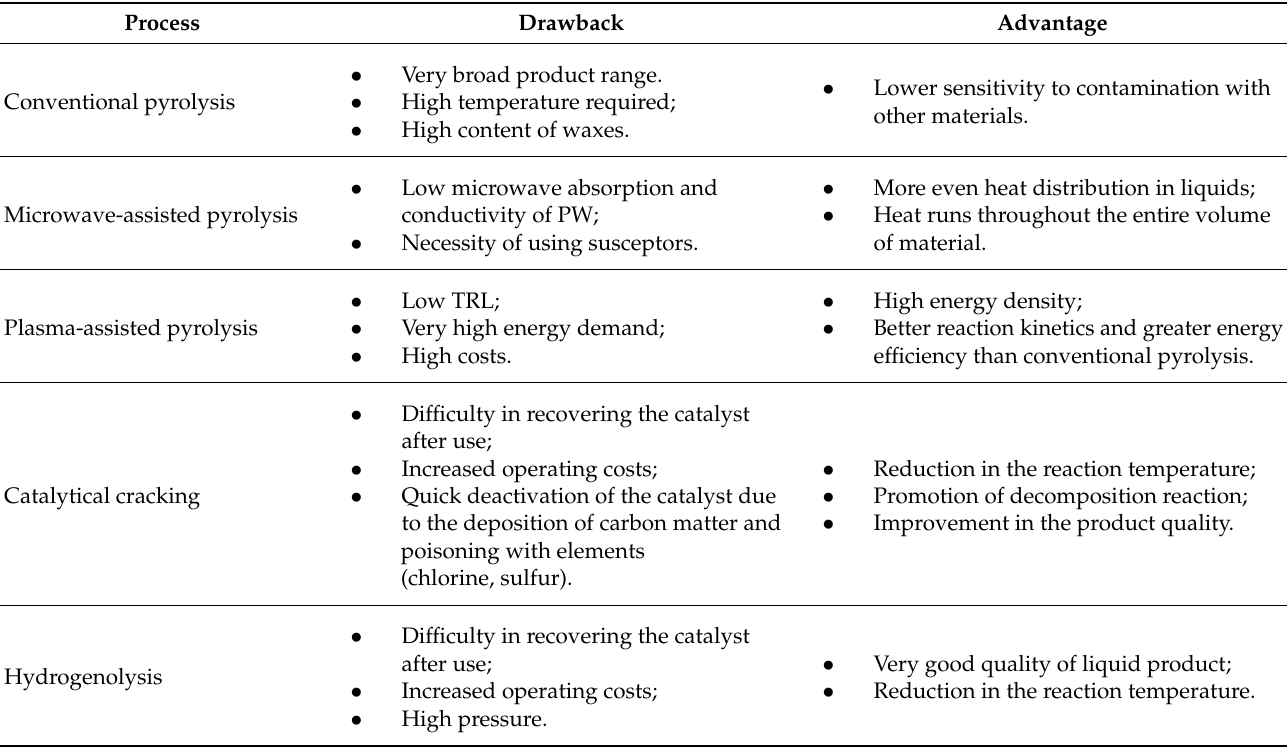
Table 5. The main advantages and disadvantages of technologies used to convert PW to